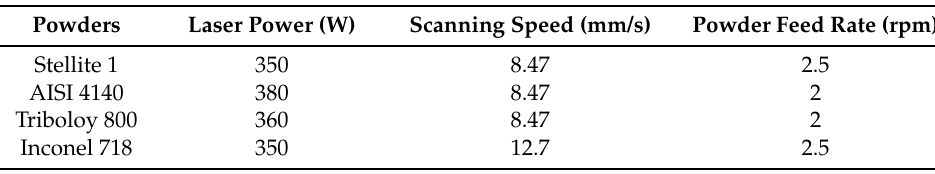
Table 4. Input parameters selected for each kind of powder.